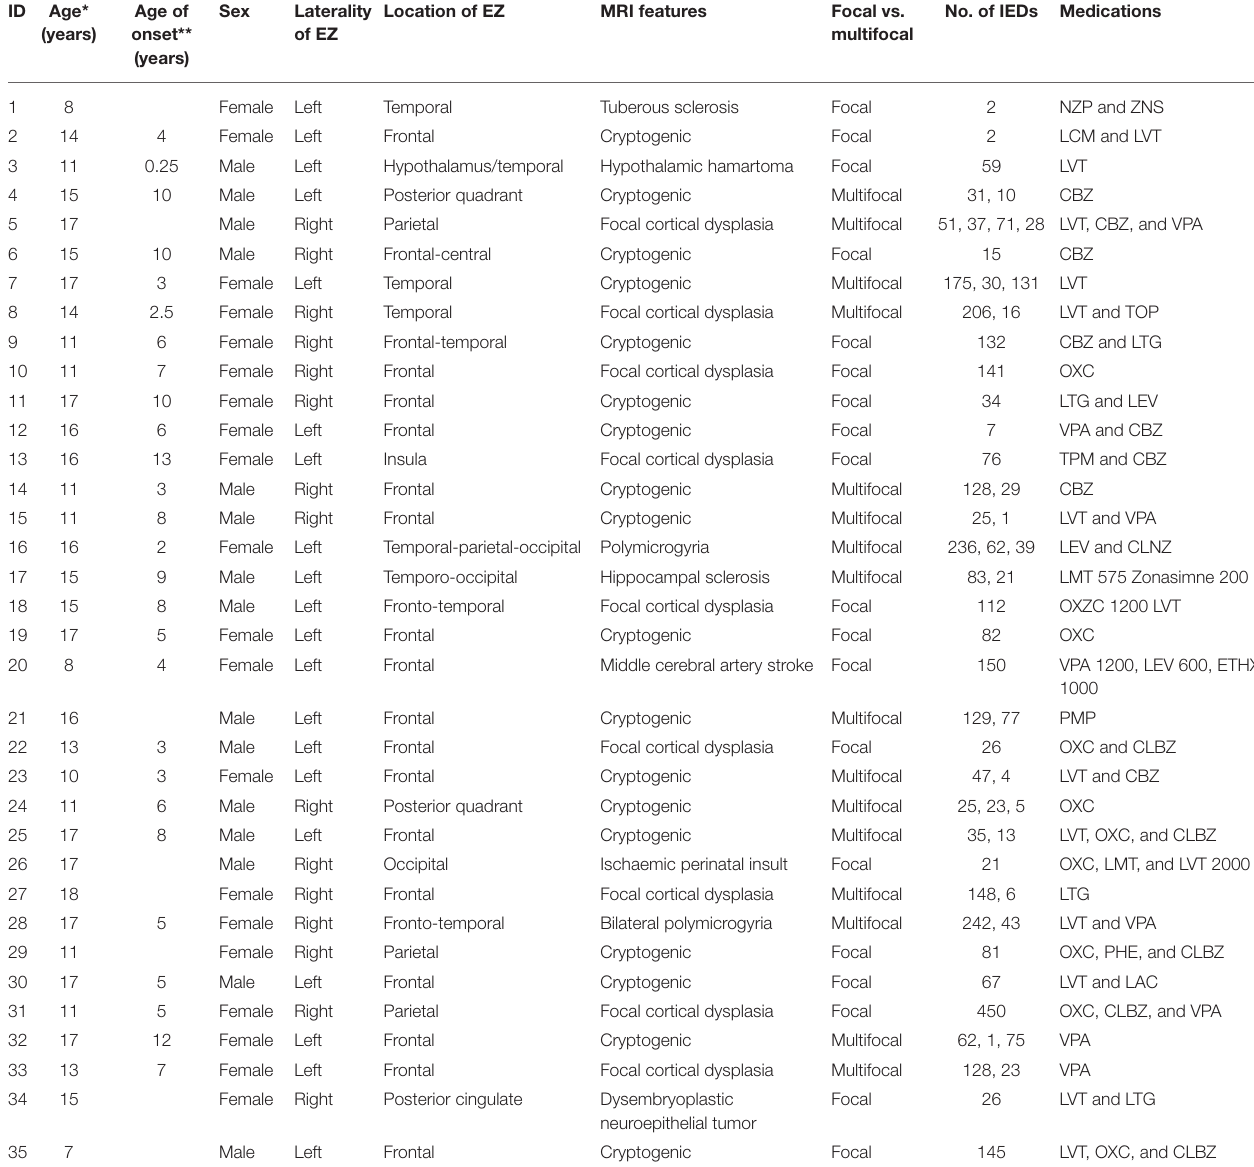
TABLE 1 | Demographic, clinical, neurophysiological, and neuroradiological descriptions of each child. ID Age*